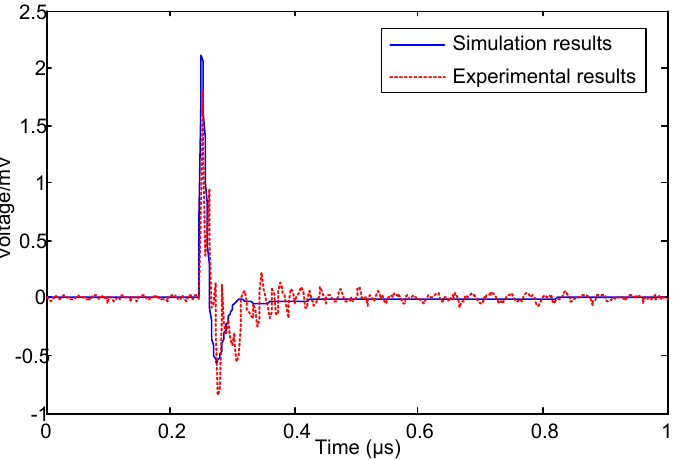
Figure 9. Comparison of the PD current between the simulation and experiment as a response to 1.5 PDIV with 10 mm needle-sphere electrode configuration.